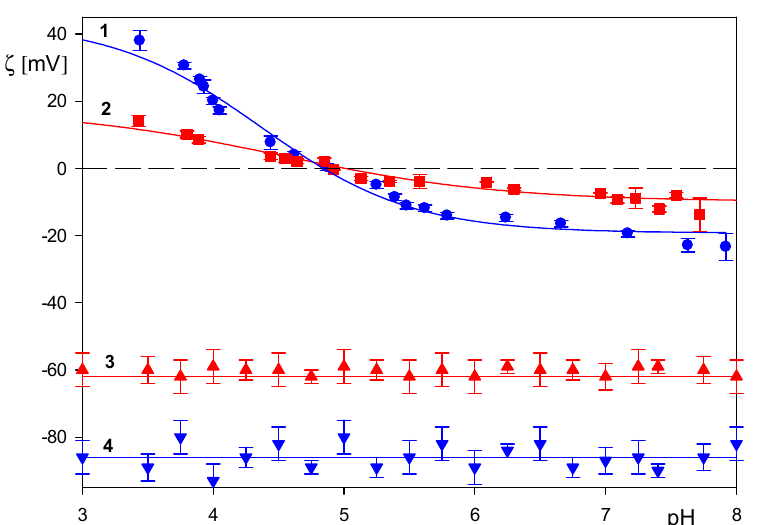
Figure 3. Dependence of the zeta potential on pH derived from the LDV measurements: (1) myo- globin in 0.01 M, NaCl; (2) myoglobin in 0.15 M, NaCl; (3) microparticles in 0.15 M, NaCl; (4) mi- croparticles in 0.01 M, NaCl. The solid lines are non-linear fits of experimental data.